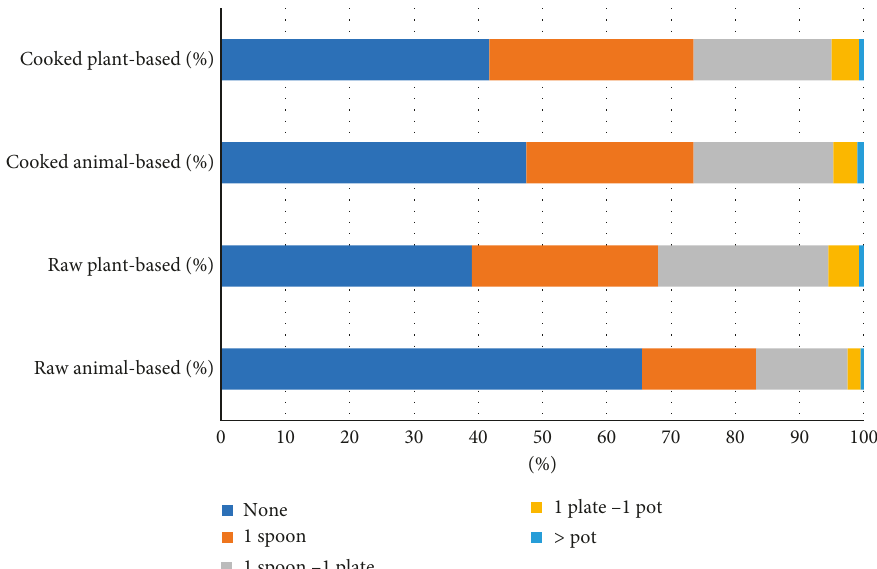
Figure 2: Food waste composition such as raw animal-based, raw plant-based, cooked animal-based, and cooked plant-based wasted as none, one spoon, one spoon to 1 plate, one plate to 1 pot, and more than one pot. The assumption was made as one serving spoon is equal to 50 grams, one plate is equal to 500 grams, and one pot is equal to 1000